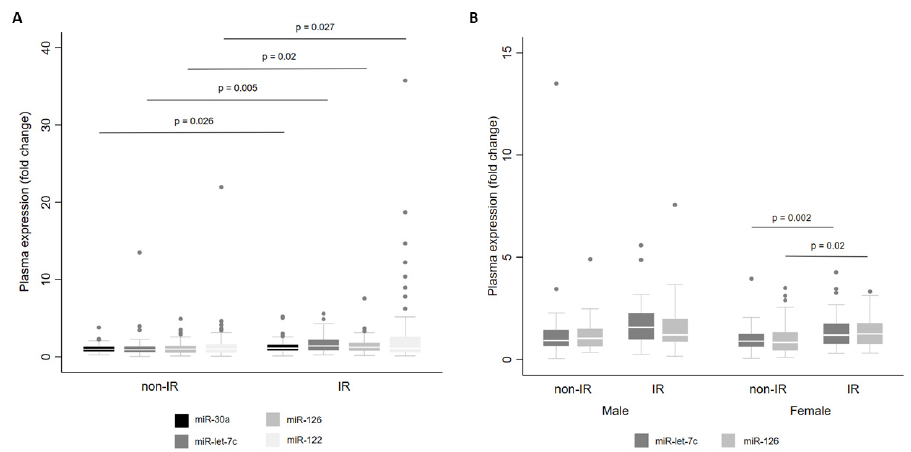
Figure 5. Levels of miR ‐ 30a, miR ‐ 122, miR ‐ 126 and miR ‐ let ‐ 7c in plasma from adults with and with ‐ out insulin resistance (IR) for the whole cohort ( A ) and by sex ( B ). Comparisons between groups were conducted using the adjusted Wald test. The box plots depict the 25th–75th percentile, and the white line represents the median of each group. p < 0.05 indicates statistically significant differences. the BMI classification (Table